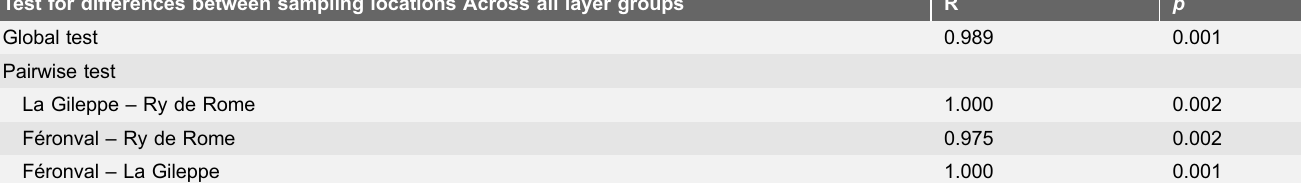
Table 3. ANOSIM significance values based on OTUs (0.03 cut-off value). Test for differences between sampling locations Across all layer